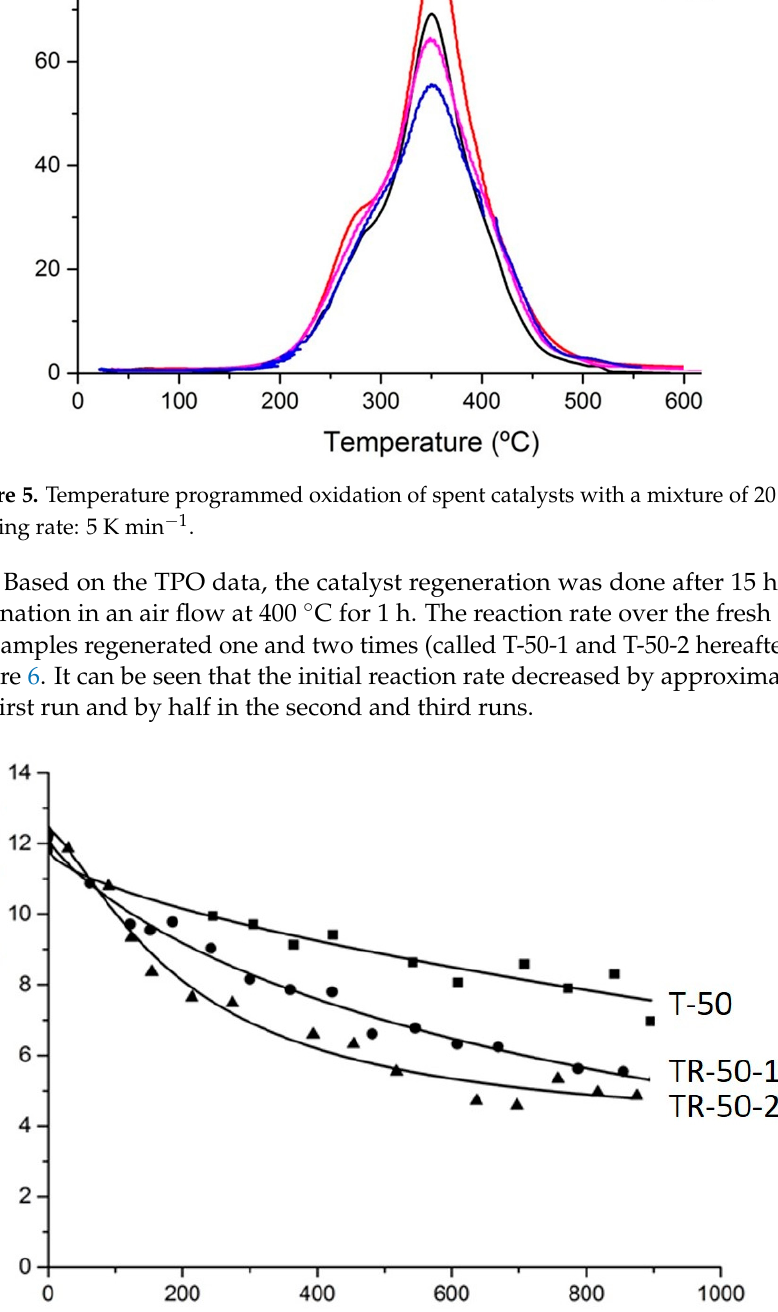
Figure 6. Reaction rate as a function of time over the fresh (T-50) and regenerated (T-50-1 and T- 50-2) catalysts. Catalyst weight: 526 mg, Reaction conditions: concentration of 4-phenylbutyric acid: 50 mmol L − 1 , concentration of aniline: 50 mmol L − 1 . Flow rate: 110 µL min − 1 . Temperature: 150 °C, pressure: 7 bar.